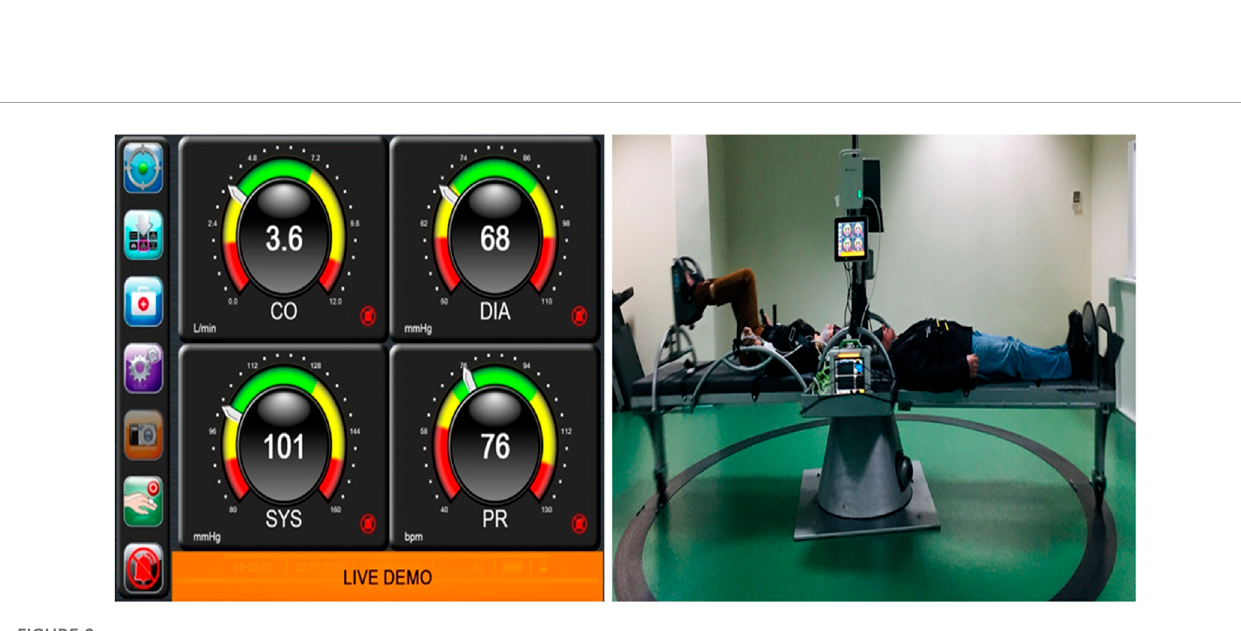
FIGURE 2 Finger plethysmography (left side) instant values of cardiovascular parameters monitored by the ClearSight device connected to the patient during centrifugationandrecordingdataevery30 s.SAHCwiththepatientsonthebeds,oneattheleftbedwithbicycleergometerandtheotherwithSAHConlyand simultaneous recordings is visualized on the right side of the